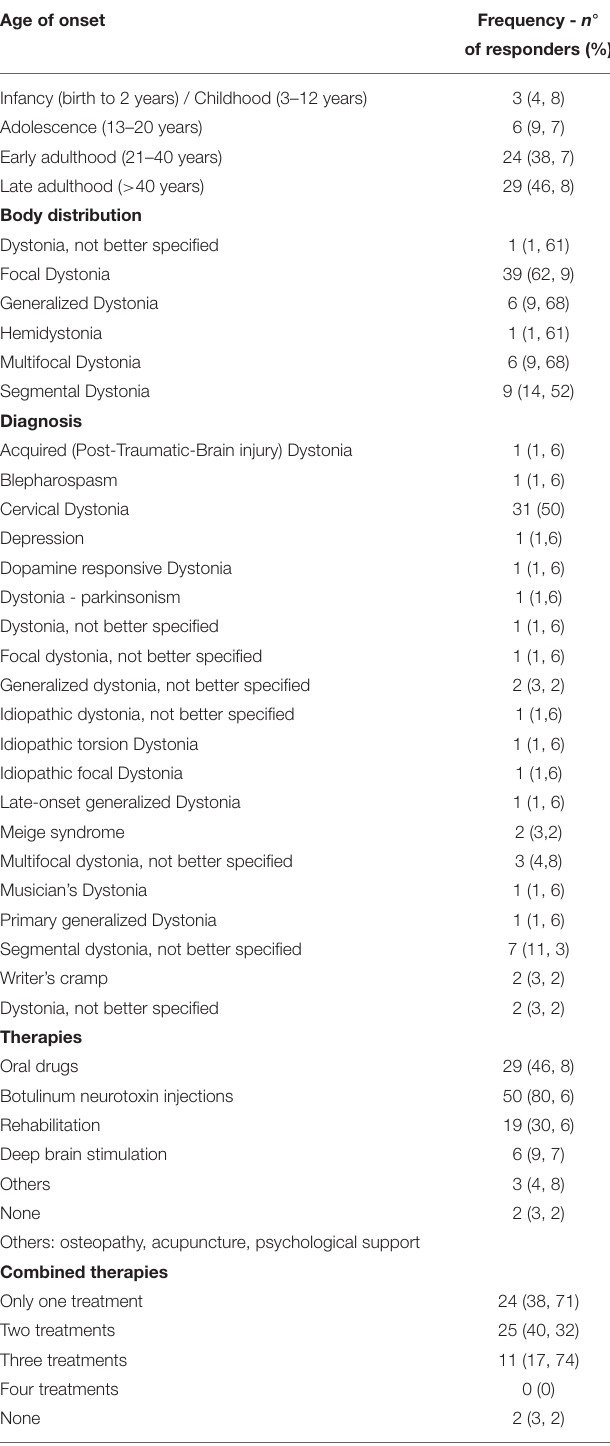
TABLE 2 | Dystonic clinical